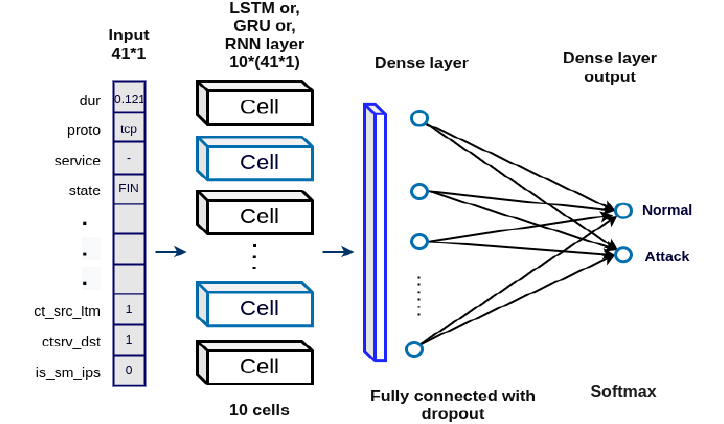
Figure 2. The three architectures which are LSTM, GRU, RNN models are illustrated. Except LSTM, GRU, RNN layers, other layers same as following layers: input layer, LSTM, or GRU, or RNN layers, Dense layer, fully connected layer and output layer.